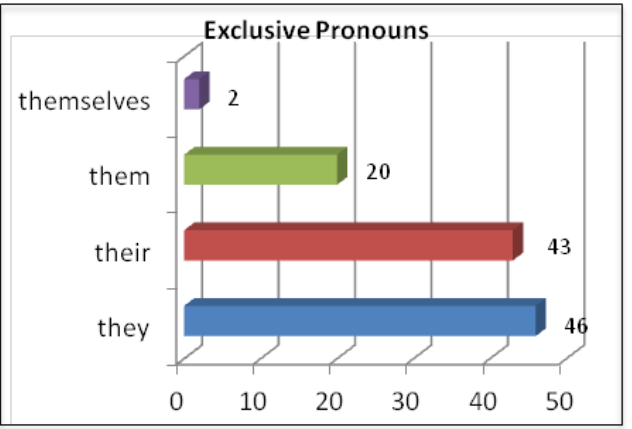
Figure 6. Exclusive pronouns in the corpus However, as opposed to the inclusive pronouns which refer to the in-group, some of the exclusive pronouns in the corpus do not refer only to the out-group but rather to some members of the anglophone in-group. These members are excluded from the in-group through the use of “they” and “their” which places them in the out-group. In Ex. 21, the underlined exclusive pronouns are directed at anglophones accused of joining the francophone out-group to subjugate the anglophone in-group for personal